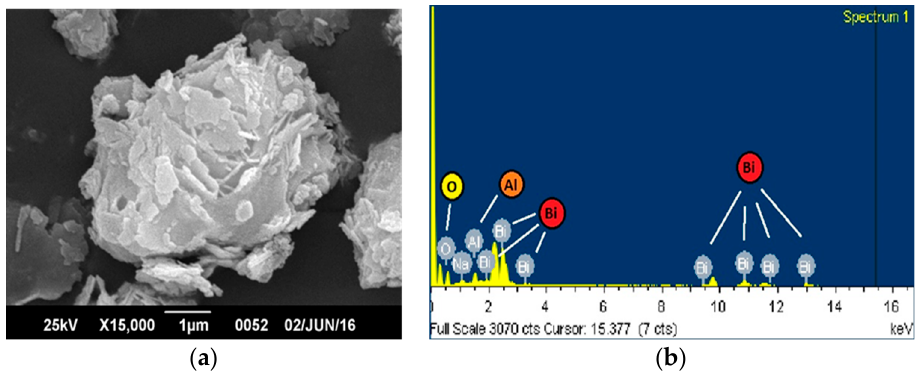
Figure 8. ( a ) SEM image, ( b ) EDX spectrum obtained for Bi 2 O 2 CO 3 :Al.